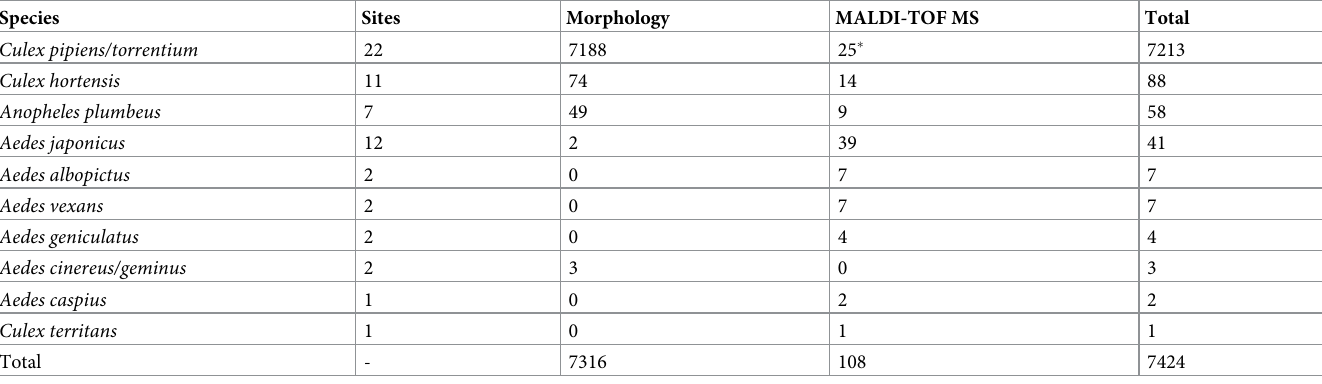
Table 2. Mosquito specimens sampled in the BG-Sentinel traps in 2014. Species Sites Morphology MALDI-TOF